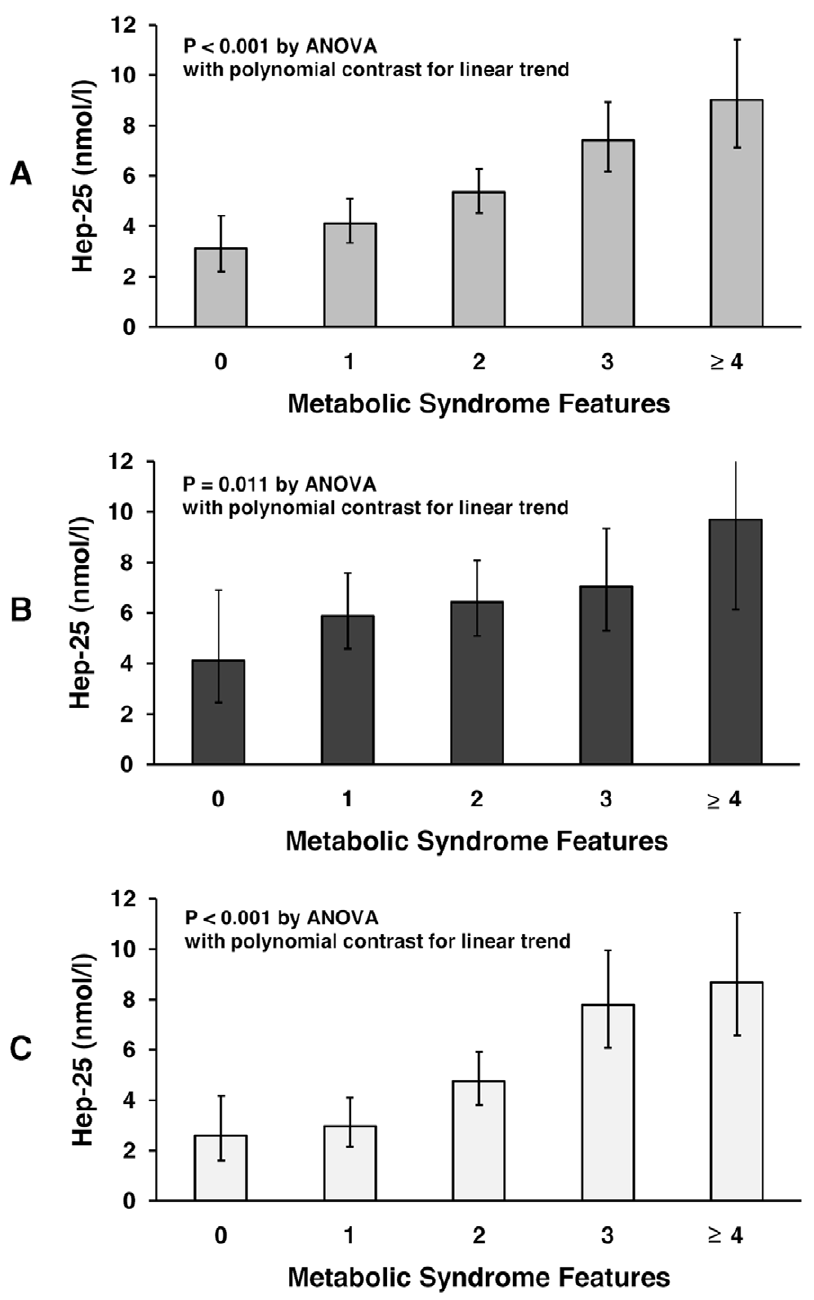
Figure 1. Serum hepcidin levels in the Val Borbera population according to increasing number of MetS features. (A) whole population, (B) males and (C) females.